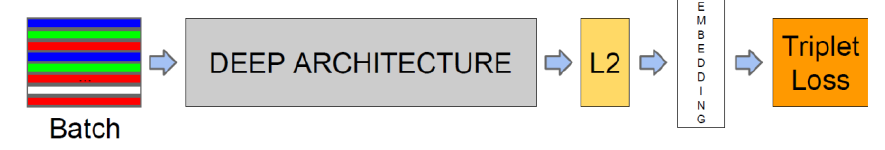
Figure 4. FaceNet structure.